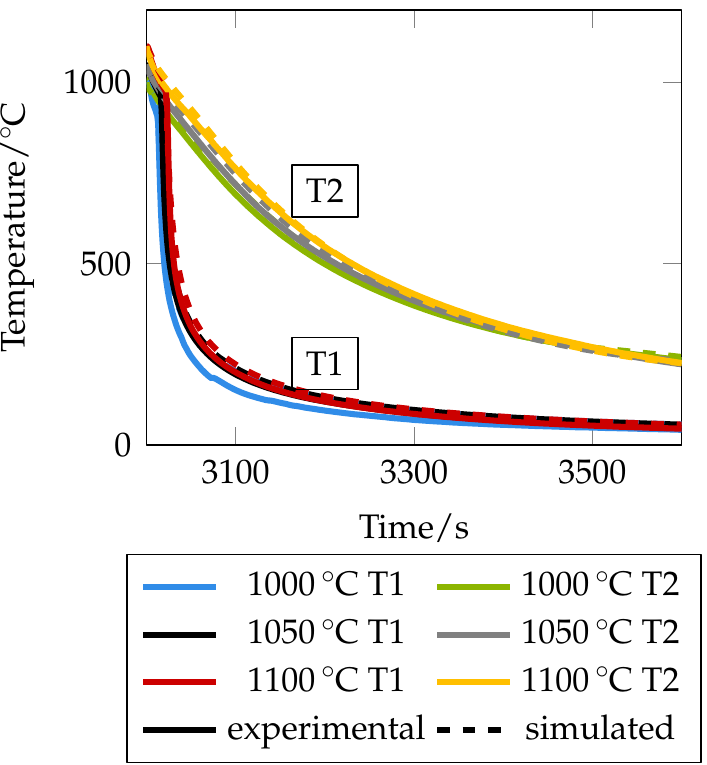
Figure 12. Comparison between experimental and simulated time-temperature sequences T1